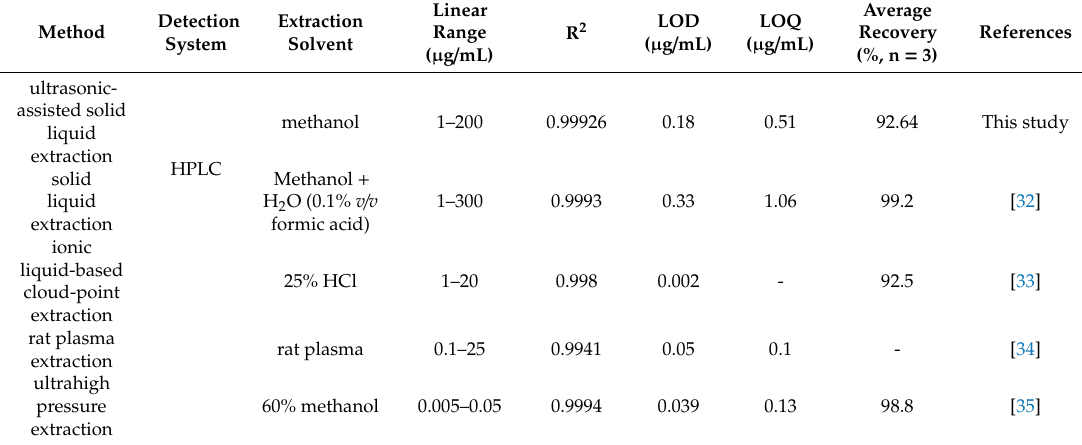
Table 3. Comparison with other reported